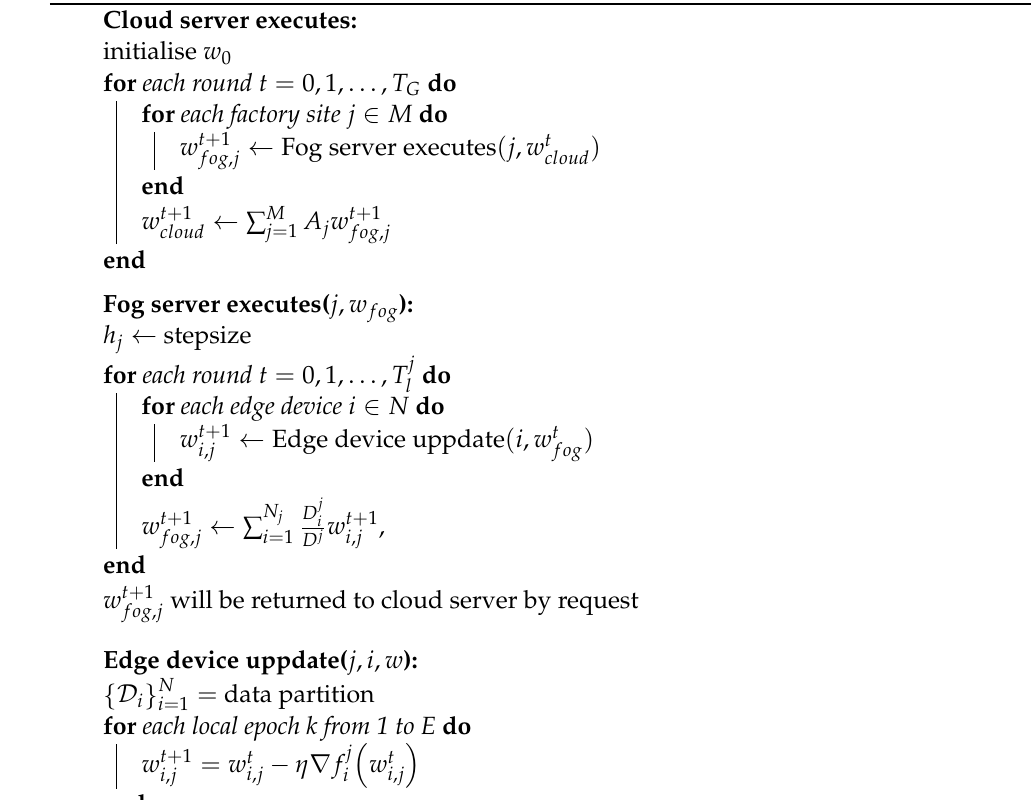
Algorithm 1: Federation on the edge, fog, and